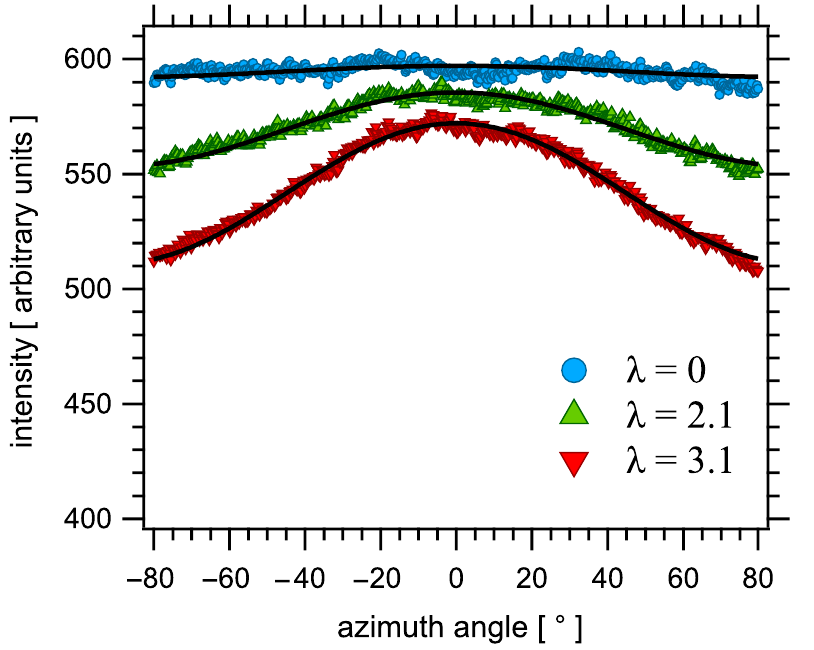
Figure 3. Representative integrated X intensity curves measured in sample S4 as a function of the azimuth angle ϕ , at various elongation ratios λ . Here, ϕ = 0 is perpendicular to the tensile direction. Symbols are measurements, curves are the corresponding fits with the expression A + B cos 2 ϕ , from which the orientation parameter (cid:104) P 2 (cid:105) is deduced. Data have been arbitrarily shifted vertically X for better